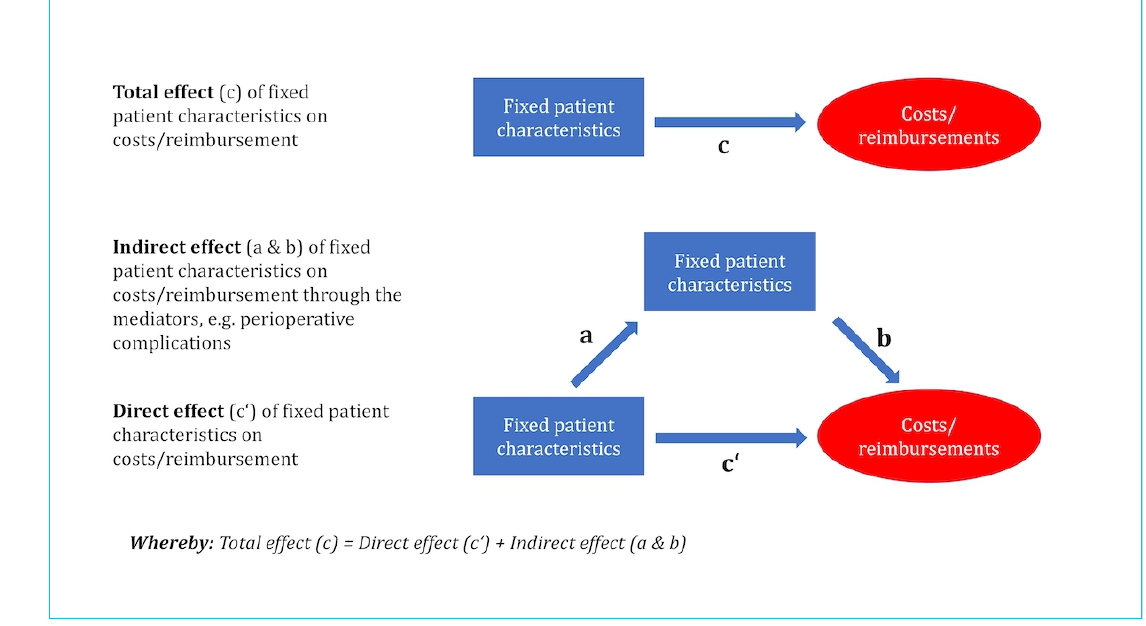
Figure 1: Direct, indirect and total effects on monetary outcomes as calculated using structural equation models. The total effect (c) corre- sponds to the sum of the direct effects (c') and the indirect effects (a and